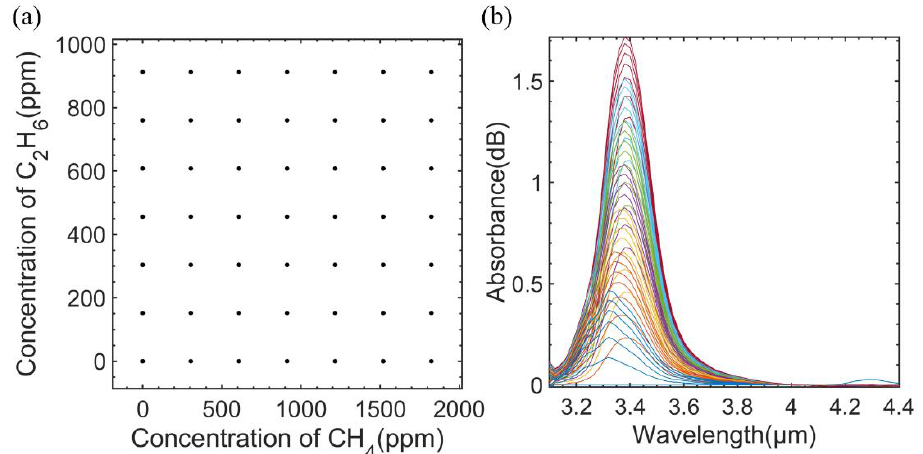
Figure 8. ( a ) Gas concentration distribution of the mixed gases. ( b ) Measured absorption spectra of mixed gases samples.